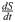
Elliptical relationships between stage, stage-rate-of-change, and discharge.Discharge (Q) relationships to stage (S, left column) or stage-rate-of-change (dSdt, right column) at five of the tidal USGS sites during two weeks of baseflow, with points colored by the other variable (dSdt, left; S, right). An ideal progressive-wave system would exhibit linear Q(S) and an ideal standing-wave system would exhibit linear Q (dSdt). Sites are: (a-b) Shark River, (c-d) Connecticut River, (e-f) Halls River, (g-h) Crystal River, (j-k) Plum Island River (see Table 1). The Shark, Halls, and Plum Island Rivers measured stage relative to a zero MSL datum, hence positive and negative stage; the Connecticut and Crystal Rivers used a lower datum. Data for these rivers was obtained from USGS NWIS [50] and visualized via MATLAB.